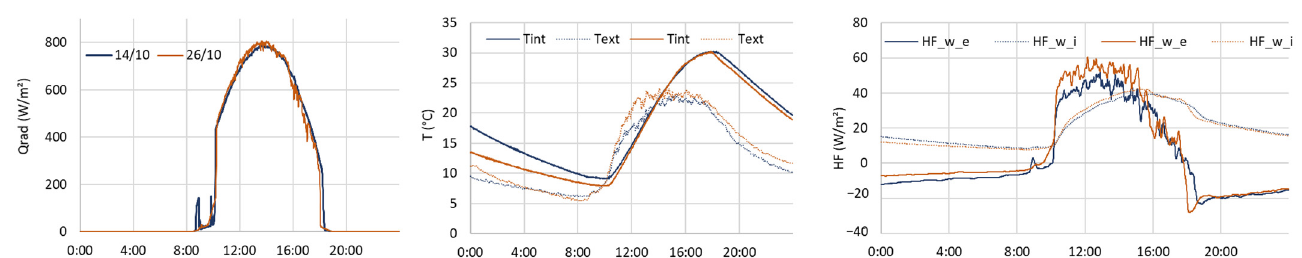
Figure 10. Layering of measurements performed on the test box during two separate days. Incident solar radiation, air temperatures, and heat flows. Measurements on 14 October 2021: closed flaps. Measurements on 26 October 2021: opened flap with a 90° angle, along a horizontal rotation axis (solar cap configuration).